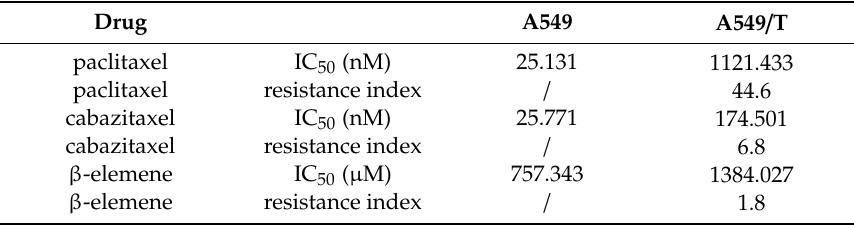
Table 1. The resistance index of paclitaxel, cabazitaxel and β -elemene. Drug